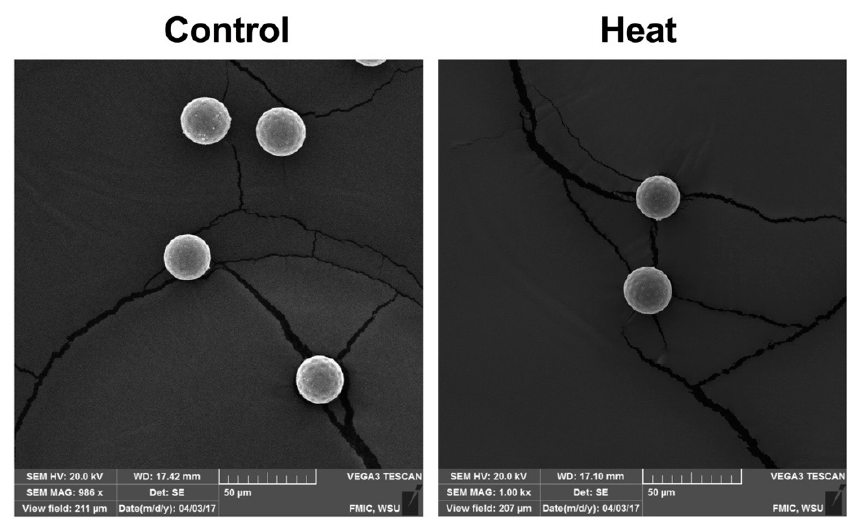
Figure 5. Scanning electron micrographs of quinoa pollen under control conditions 25/16 °C and heat conditions 40/24 °C, magnification 1000×